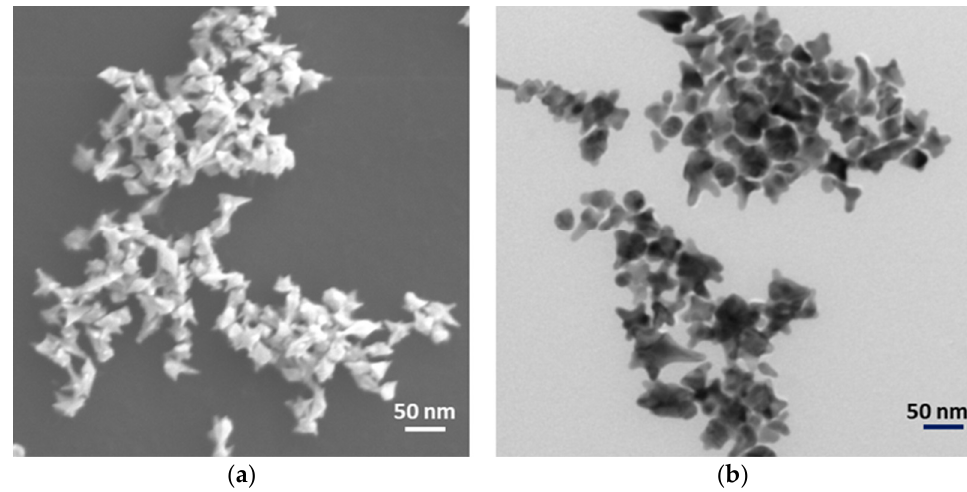
Figure 2. Nanostars under ( a ) Scanning and ( b ) Transmission Electron microscopy .